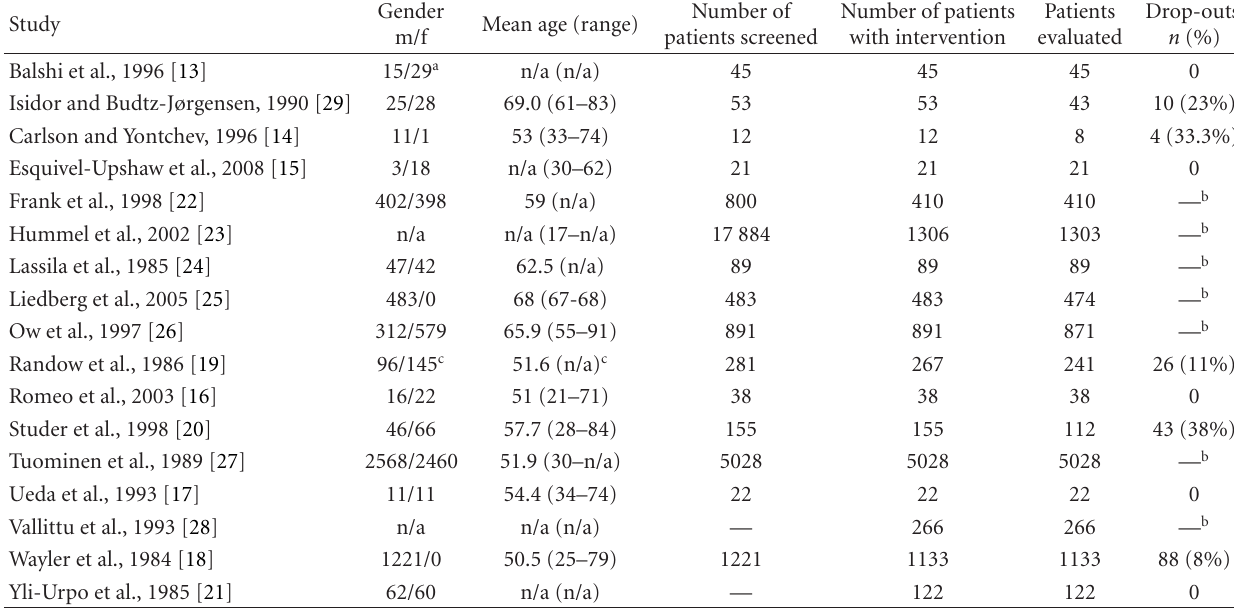
Table 2: Description of patient